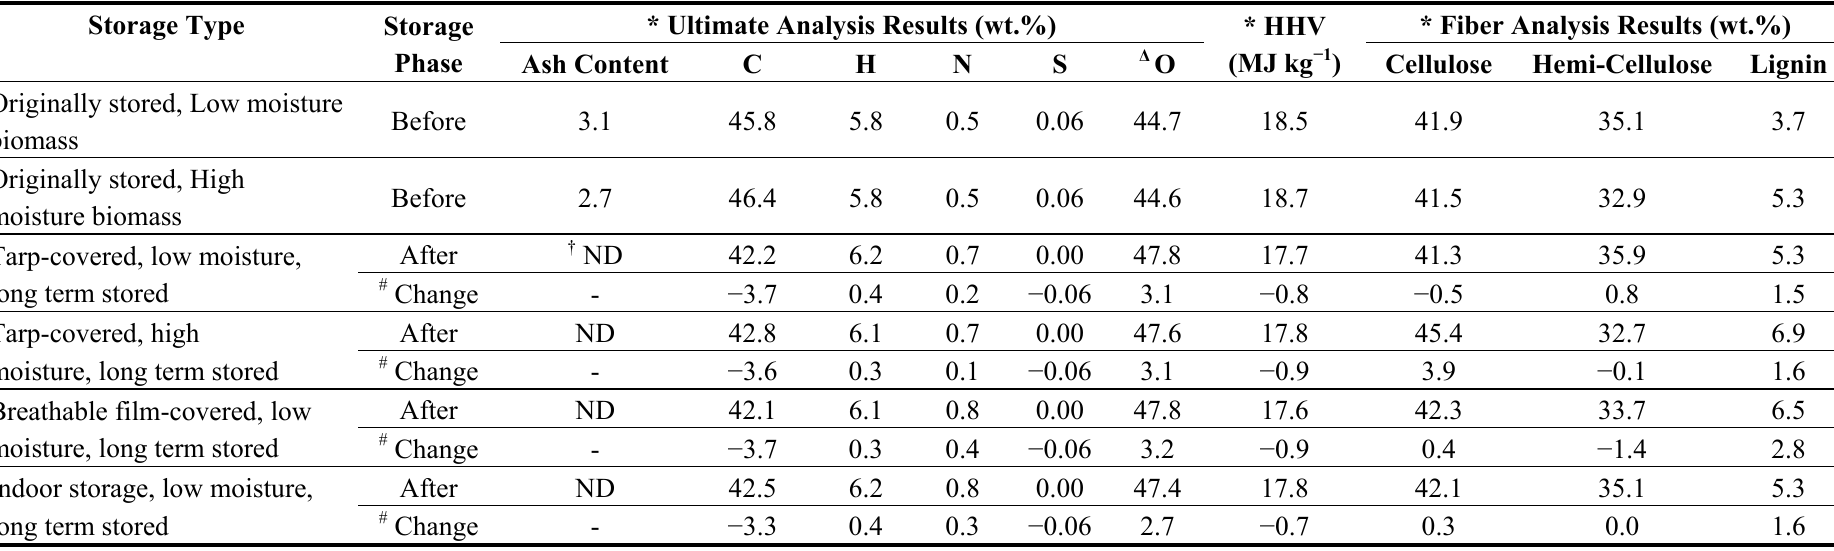
Table 3. Summary of chemical properties of bales stored under different treatment